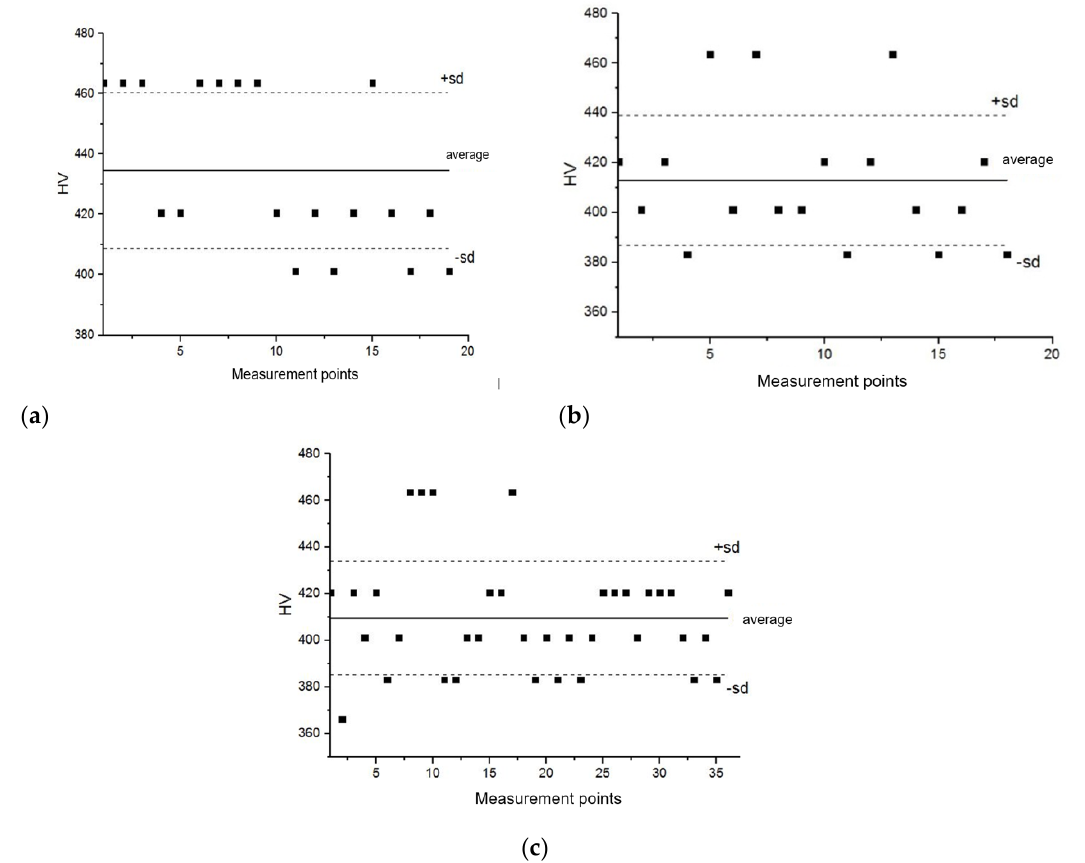
Figure 16. Statistical distribution of the microhardness of the material of the HPT blade in the overheated zone ( a ), in the non-overheated zone ( b ), and in the material of the LPT blade ( c ).